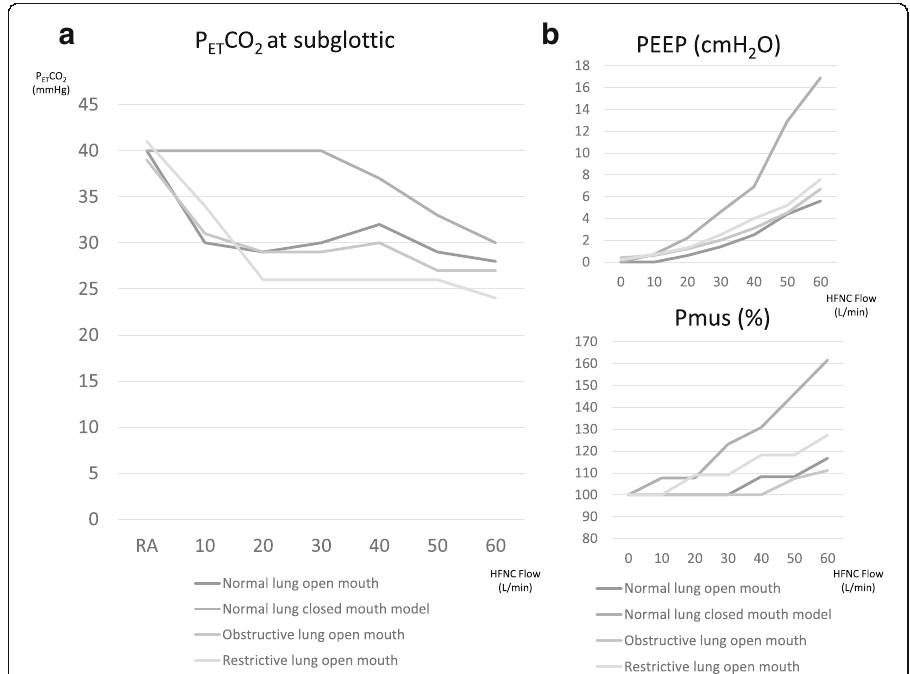
Fig. 4 Relationship between P ET CO 2 , PEEP, and inspiratory effort to maintain Vt. a P ET CO 2 measured at the subglottic site in each respiratory model. P ET CO 2 in the open-mouth models reaches a minimum value with a relatively low flow. The closed-mouth model required more flow to establish the washout effect. b The Pmus needed to maintain the initial Vt without HFNC was counted as 100%. As HFNC flow was raised,